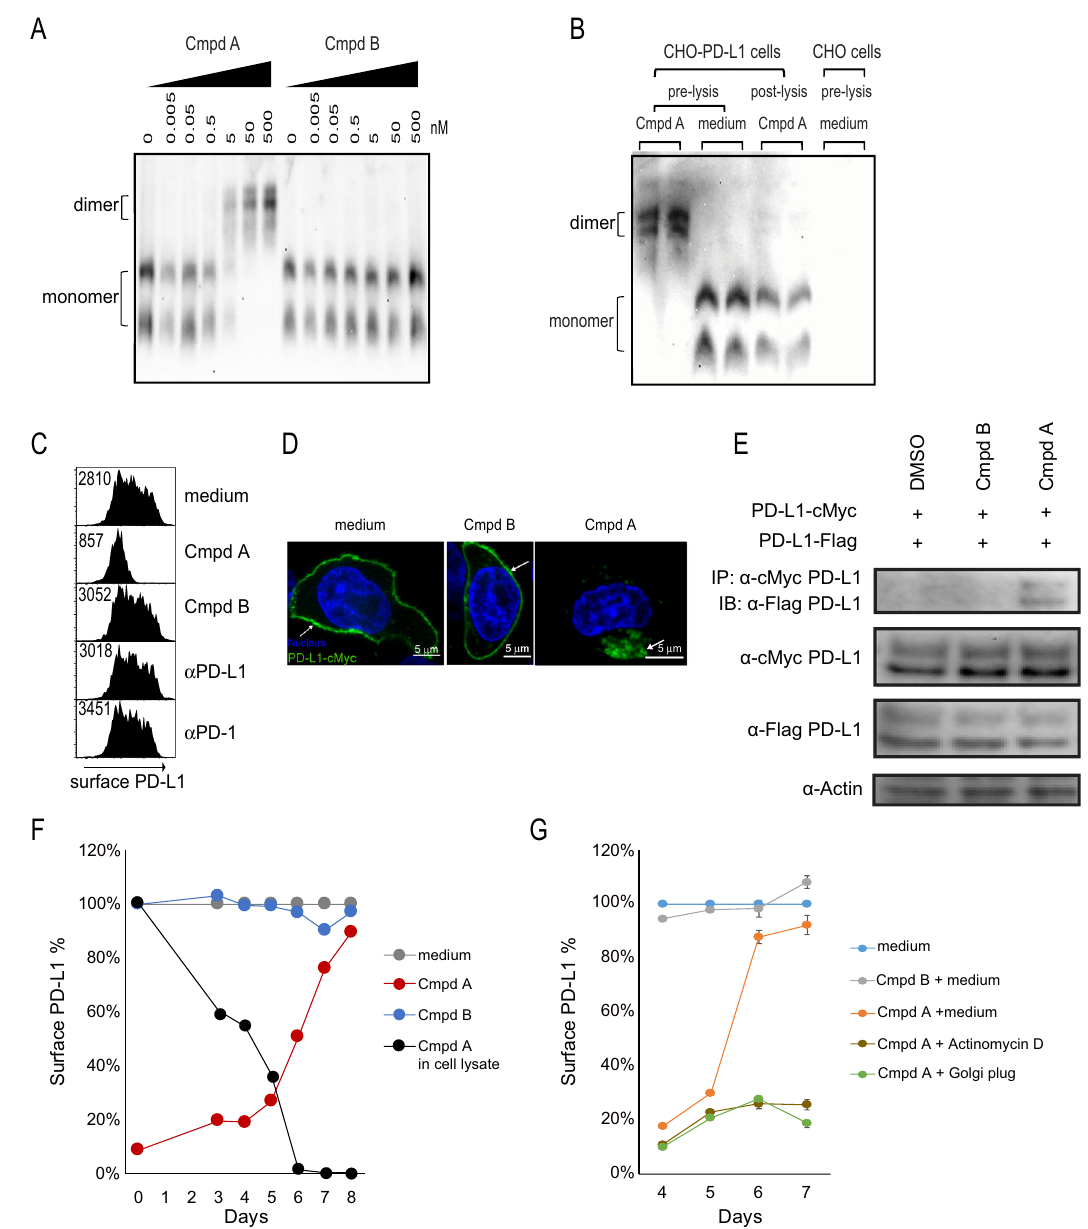
Fig. 2 Mechanism of action of compound A. a PD-L1 aAPC/CHO-K1 cells were treated with 0 – 500nM compound A or compound B. PD-L1 protein visualized by native gel electrophoresis. b Native gel electrophoresis of PD-L1 protein following pre- and post-lysate treatment with compound A. c PD-L1 aAPC/CHO-K1 cell line was treated with compound A, α PD-1/ α PD-L1 antibodies, or no treatment followed by cell surface PD-L1 detected by fl ow cytometry. Values inside histogram represent GeoMean fl uorescence intensity. d CHO-K1 cells transfected with cMyc-PD-L1 and labeled with anti-cMyc Alexa Fluor 488-conjugated antibody followed by incubation with compound A. The confocal fl uorescence microscopy detects PD-L1-cMyc (green) and nucleus (blue). Images are representative of three experiments and a minimum of 50 cells observed in each experiment. e Whole-cell extracts of CHO-K1 cells co- transfected with cMyc-PD-L1 and Flag-PD-L1 were incubated with media + 0.5% DMSO, inactive (cmpd B) or active (cmpd A) compound, and subjected to immunoprecipitation (IP) with anti-cMyc magnetic beads and immunoblot with anti-Flag antibody. Blots are representative of three experiments. f PD-L1 aAPC/CHO-K1 cell line treated with compound A to allow for loss of cell surface PD-L1, followed by daily media washes. Black line represents diminishing concentration of compound A as measured by LC-MS. Red line represents reconstitution of cell surface PD-L1 as measured by fl ow cytometry of ≥ 10,000 cells per time point. g Compound A wash off and PD-L1 cell surface reconstitution in the presence of transcriptional inhibitor (actinomycin D) and protein transport inhibitor (golgi plug). Inactive compound B (gray line) referenced as negative control. Source data are provided as a Source data fi Antitumor effects of small-molecule PD-L1 inhibition . Anti- In these humanized PD-1/PD-L1 mice implanted with the col- tumor ef fi cacy of compound A treatment was evaluated in mice orectal cancer cell line MC38, compound A treatment at 10 mg/kg expressing humanized PD-1 and PD-L1, in which the extra- for only 7 days resulted in 60.4% group mean tumor cellular domains of murine PD-1 and PD-L1 were genetically volume reduction (relative to vehicle control) with four out of replaced with the human extracellular domain counterparts 25 – 27 . eight animals exhibiting response similar to those observed in the